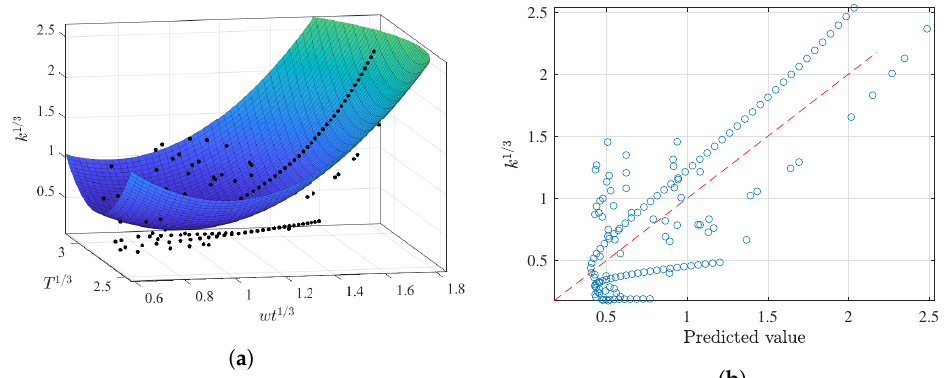
Figure 14. Best polynomial regression result of k in terms of wt and T for the AS dataset: ( a ) fitting results and ( b ) prediction capabilities.